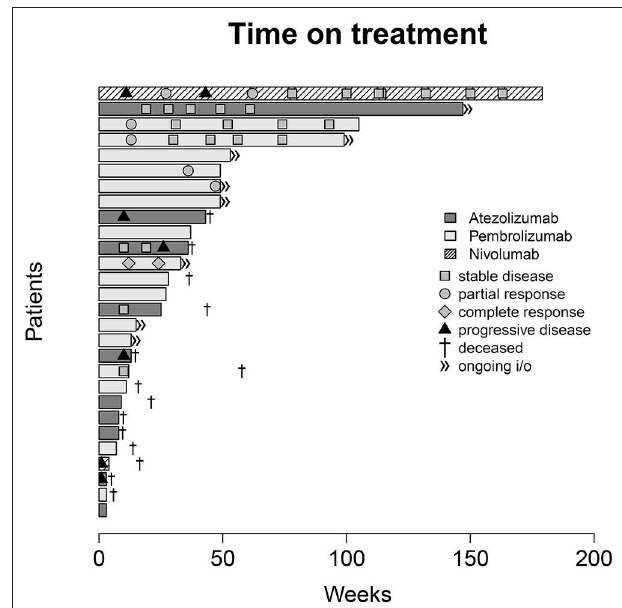
FIGURE 6 | Swimmer plot indicating duration of checkpoint inhibitor monotherapy, overall survival and radiological response according to the Response Evaluation Criteria in Solid Tumors [RECIST v1.1